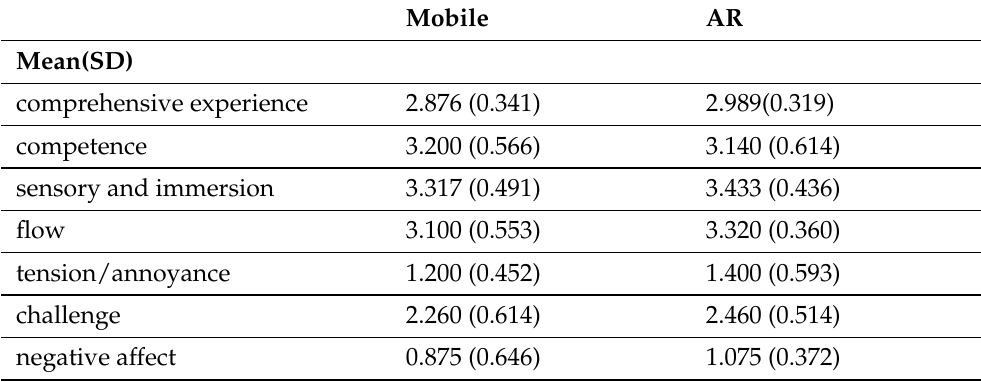
Table 2. User experience analysis results for English language teaching applications using the text